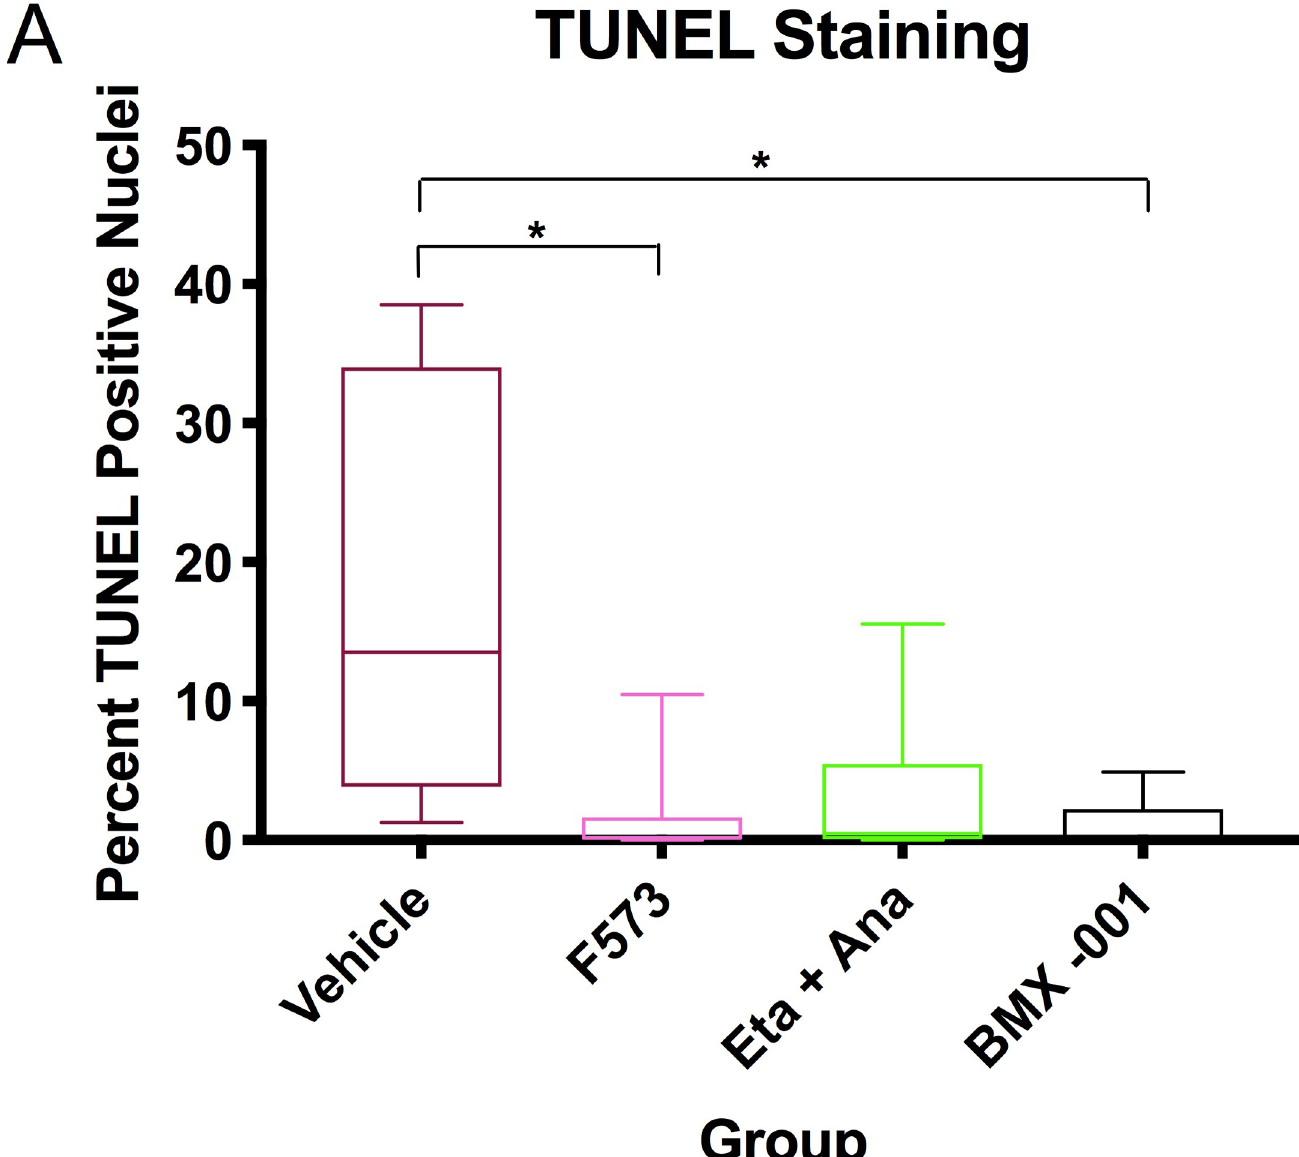
Fig 2. Liver tissue TUNEL staining. (A) TUNEL staining of tissue samples, reporting relative percentage of TUNEL nuclei compared to DAPI. Significantly lower TUNEL staining was found in the F573 and BMX-001 groups (p = 0.03 and p = 0.01, respectively). Data points show means and SEM, 95% confidence interval (n = 7 per